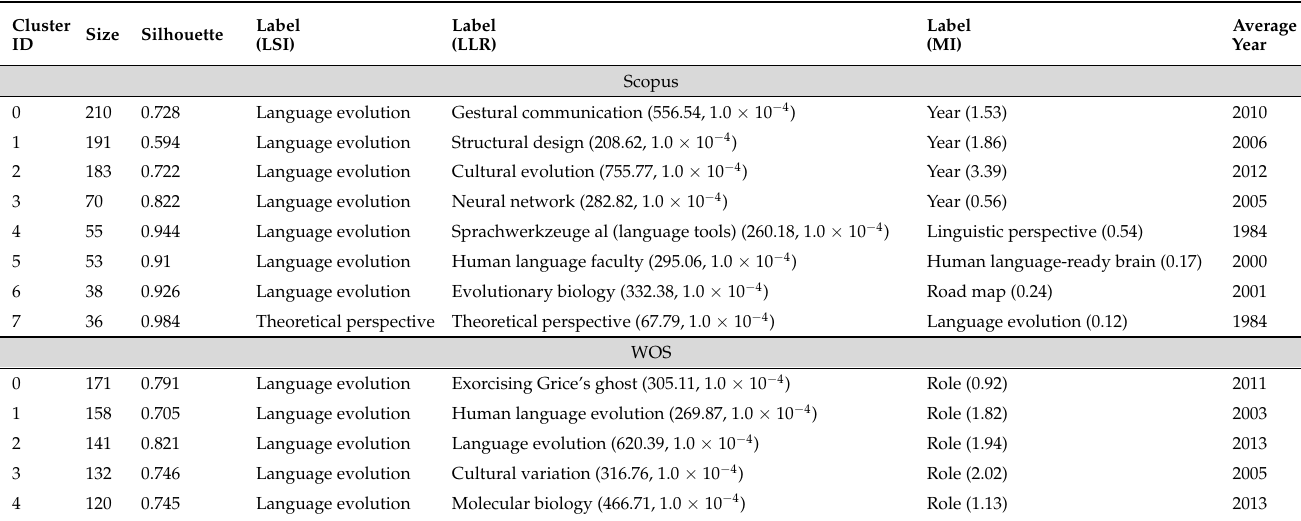
Table 4. Summary of the largest clusters of biolinguistics using scientometric indicators.